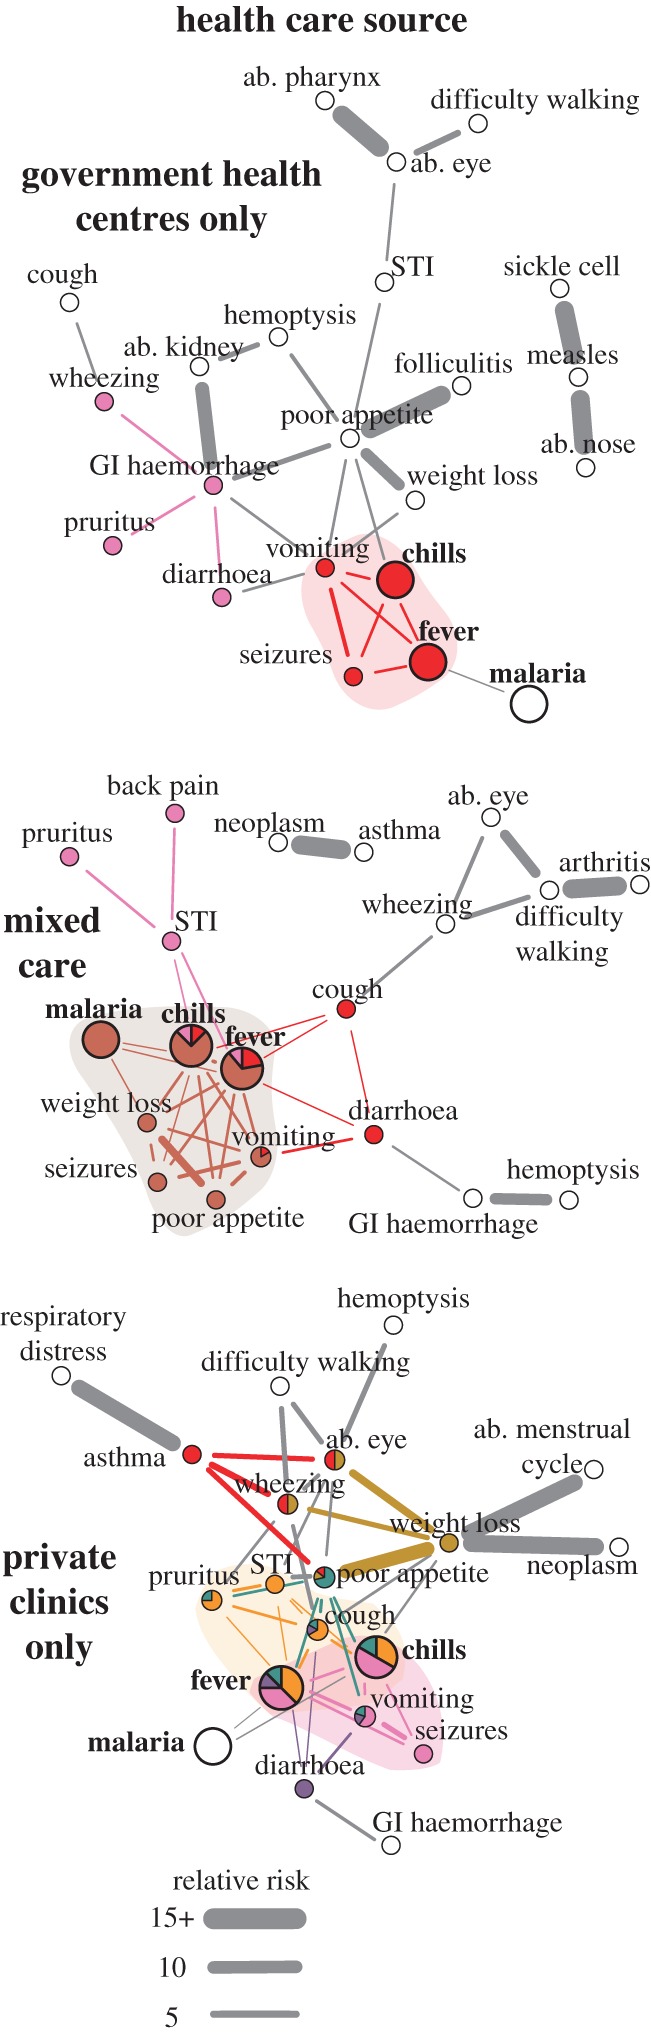
Comorbidity by type of healthcare accessed. Nodes represent reported symptoms/diseases; HPO terms are shown for symptoms. ab. ‘abnormality of the’, GI ‘gastrointestinal’ and STI ‘sexually transmitted infection’. Edges shown had relative risk (RR) > 1, ϕ > 0 and q-value < 0.05. Widths of edges are capped at a RR of 15. Colours correspond to link clusters; grey edges and white nodes were not grouped into a link cluster. The main clusters for fever are shaded as a visual aid. A main cluster was where a majority of edges for fever were grouped. If there was no majority, all clusters with greater than 1 edge with fever were highlighted/shaded. Bolded and enlarged nodes were the symptoms/diseases that were most often co-reported with another illness. A force-directed layout for comorbidity networks was used; the most connected symptoms/diseases are shown in the centre of the graphs.